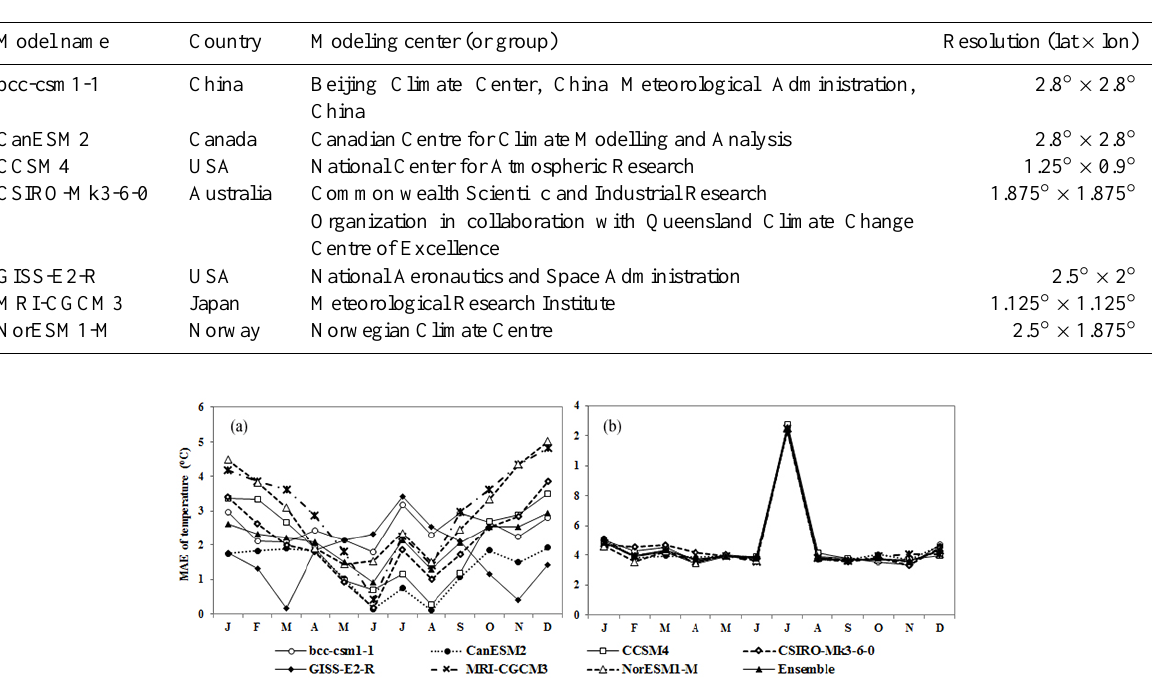
Table 1. Information of 8 global coupled climate models.